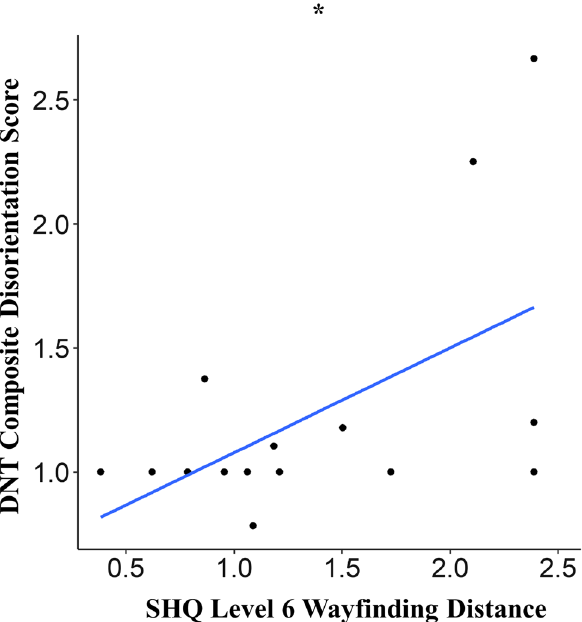
Figure 4. Linear regression model. Patient performance on SHQ level 6 wayfinding distance significantly predicted their DNT composite disorientation score ( p = 0.034, R 2 = 0.29). Adapted from 59